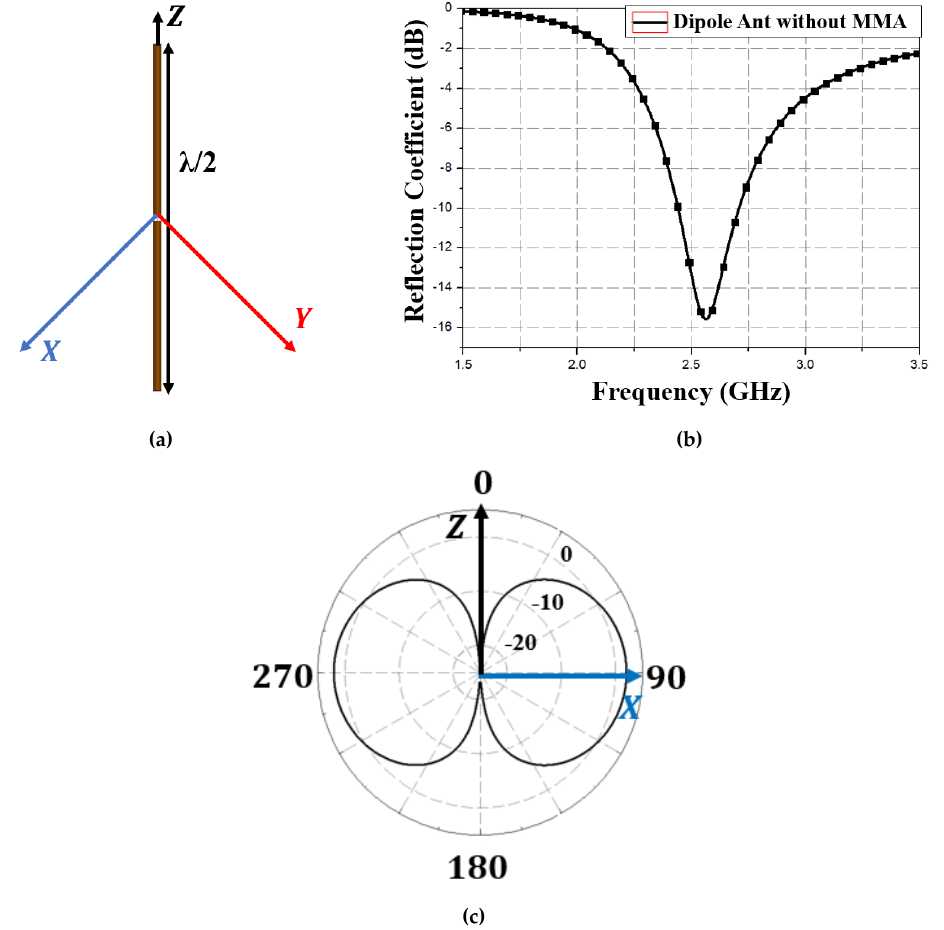
Figure 14. Dipole antenna ( a ) geometry ( b ) simulated reflection coefficient, and ( c ) two-dimensional radiation pattern at ϕ = 0 and 90°.